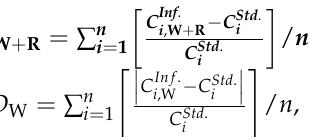
Figure 13. Real-time resistance change of the GaIn-BiInSn filled region under ( a ) pressure from 0 to 0.5 MPa and ( b ) strain from 0 to